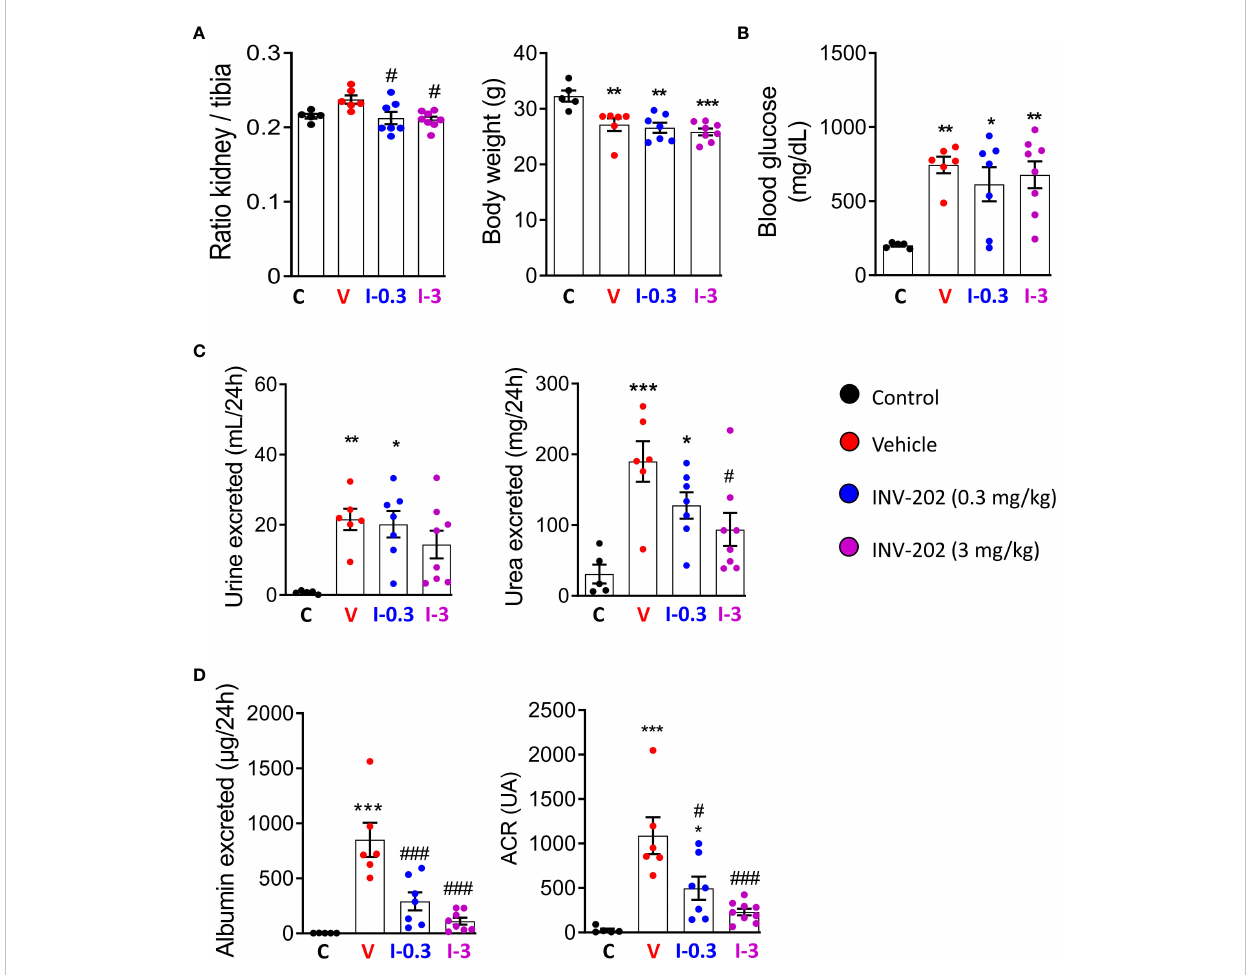
FIGURE 2 INV-202 treatment effects on different parameters associated with diabetic nephropathy. (A) Relative kidney mass and body weight following treatment. (B) Glycemia following treatment. (C) Polyuria and urinary urea following treatment. (D) Albumin excretion and urinary ACR following treatment. Statistical signi fi cance versus nondiabetic control: *p < 0.05; **p < 0.01; ***p < 0.001; versus vehicle: #p < 0.05; ###p < 0.001. ACR, albumin to creatinine ratio. C: non-diabetic control mice, V: Vehicle-treated diabetic mice, I-0.3: INV-202-treated diabetic mice (0.3 mg/kg), I-3: INV-202-treated diabetic mice (3